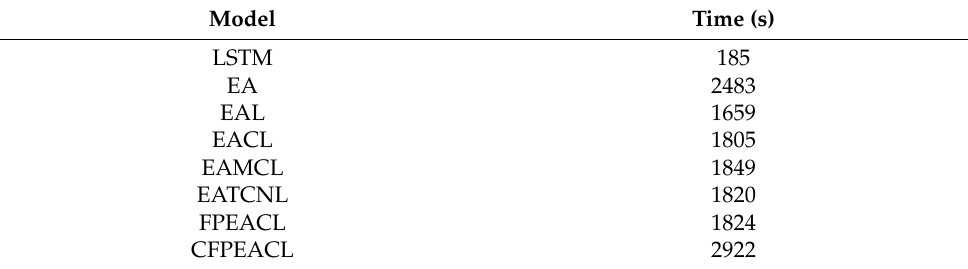
Table 8. Model training time